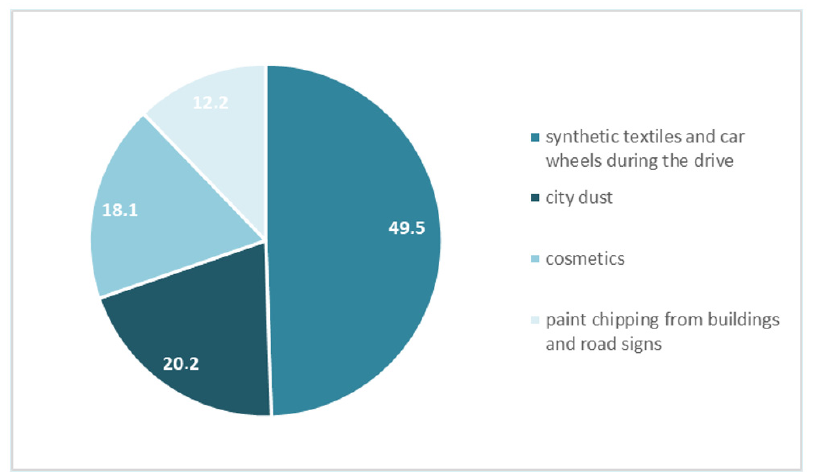
Figure 3. Respondents’ answers to “What is the source of so-called primary microplastics?” (%) .